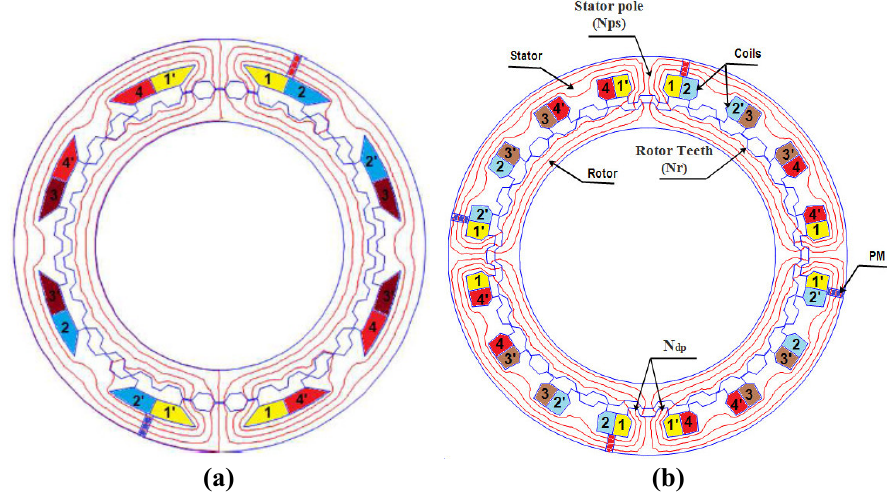
Figure 1. Proposed 4-phase TDSPM machine, ( a ) with two coils/phase, ( b ) with four coils/phase.